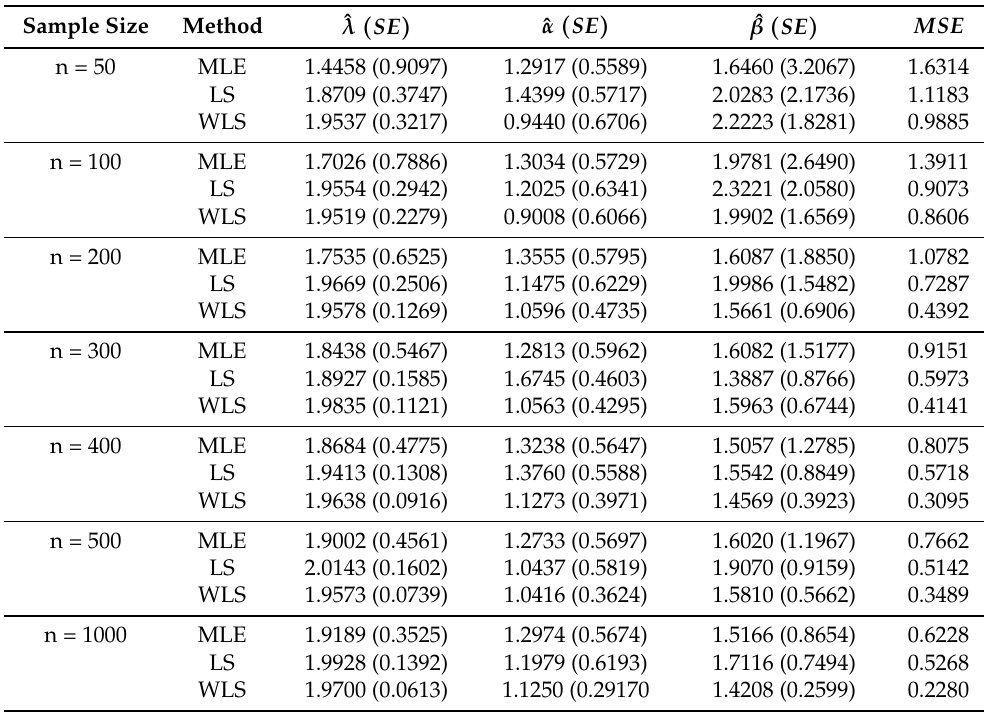
Table 2. λ = 2 , α = 1 , β =